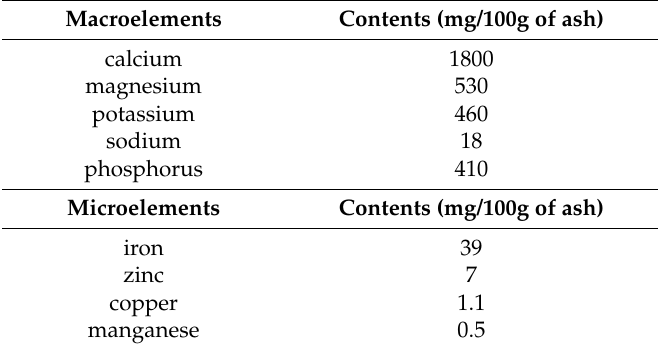
Table 4. Macroelements and microelements contributing to seed ash